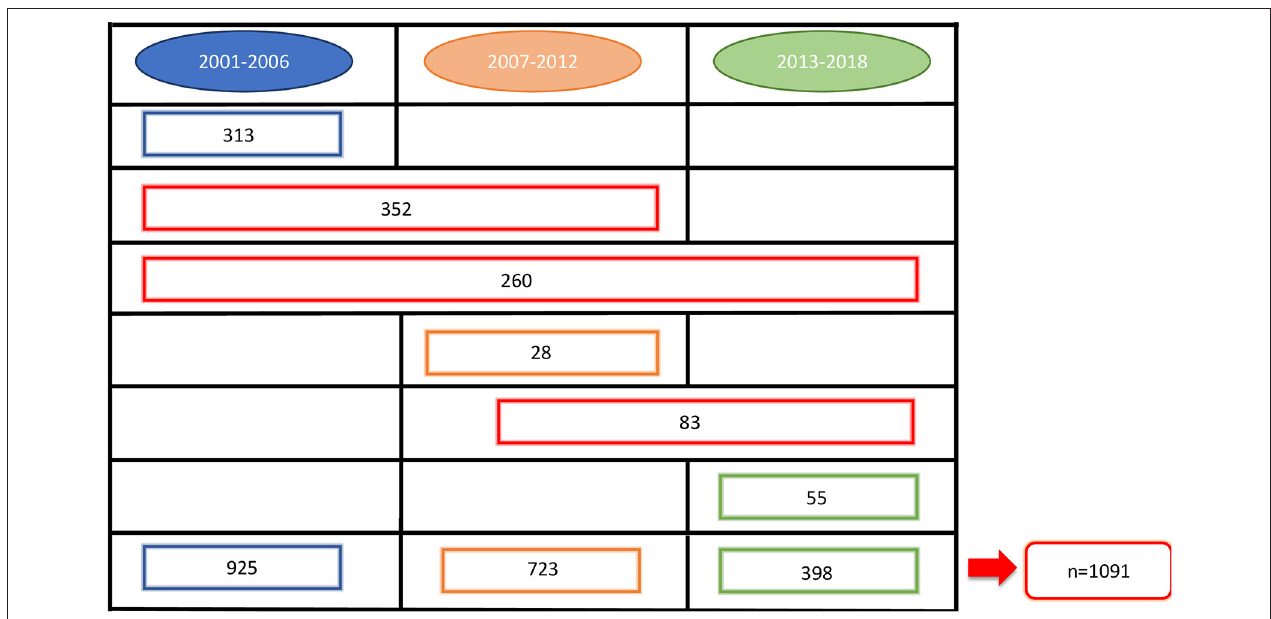
FIGURE 2 | Number of children who contributed to the three periods of analysis.